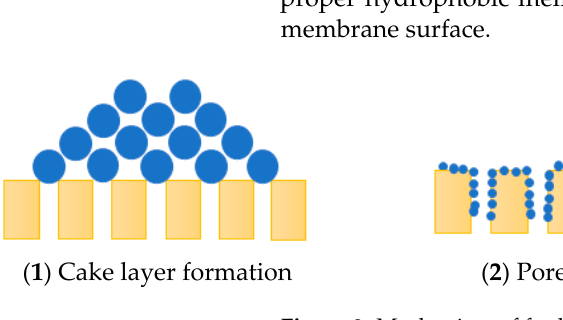
Figure 5. Number of publications of fluoropolymers applied in membrane distillation and mem- brane crystallization in the past 10 years in Web of Science (searched by using the key words “fluor- opolymer membrane”, “membrane distillation” and “membrane crystallization”). The review structurally reports the details on membrane distillation and membrane crystallization processes and the fluoropolymer membranes usually utilized. The prepa- ration methods of fluoropolymer membranes and their modification methods are also re- viewed. Among all the membrane preparation techniques, non-solvent-induced phase separation (NIPS), thermally-induced phase separation (TIPS) and vapor-induced phase separation (VIPS) are described in detail. Membrane modification methods include sur- face coating method, grafting method and blending method. In addition, some new 0 100